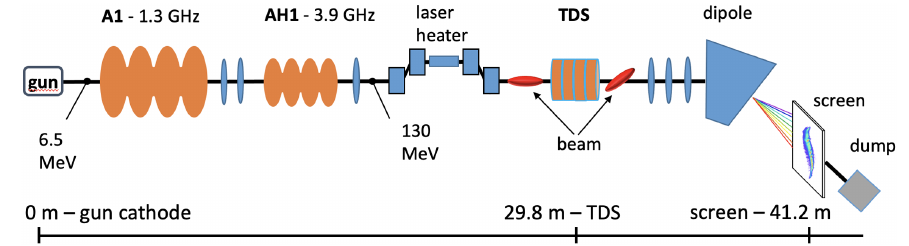
FIG. 1. The setup of the experiment at the injector section of the European XFEL.